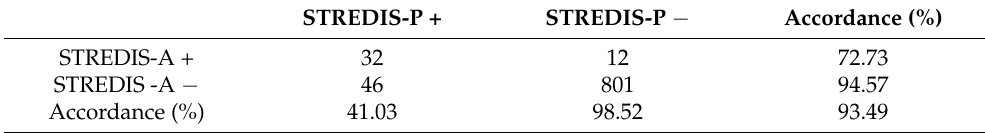
Table 6. Absolute frequencies and accordance of adolescents positively and negatively screened with